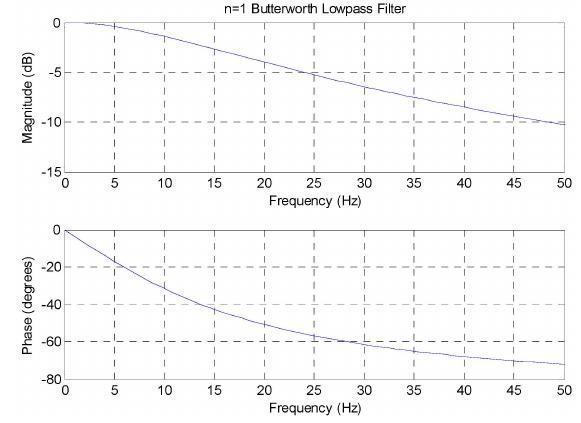
Figure 11. Frequency characteristics of a Butterworth low-pass filter.